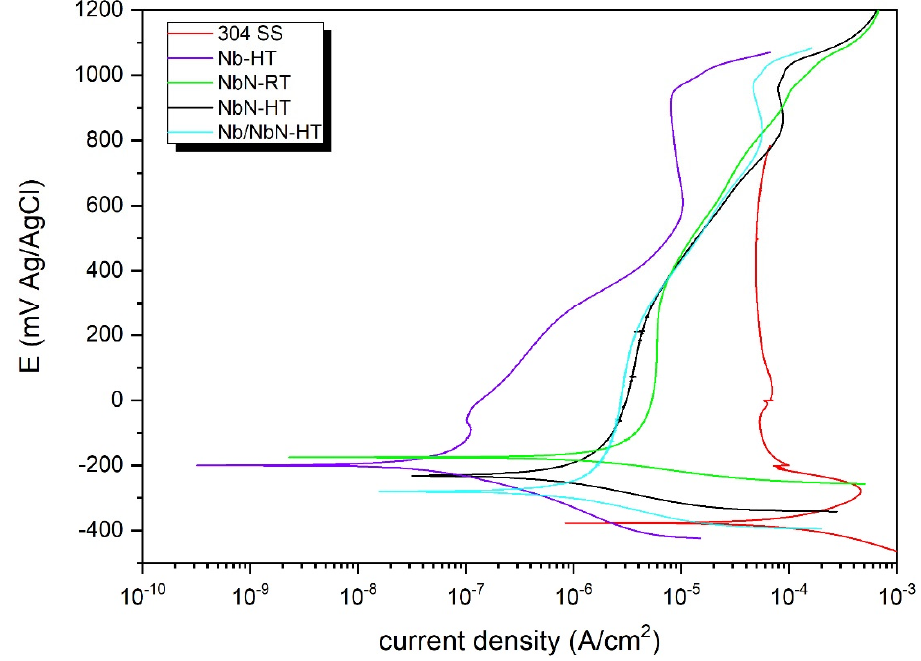
Figure 8. Potentiodynamic polarization curves of the uncoated 304 SS and different coatings in 1 M H 2 SO 4 + 2 mg/kg HF solution at 70 °C. Table 8. Electrochemical features of bare and coated 304 SS tested in simulated PEM fuel cell solution. ( E corr : corrosion potential and i corr : corrosion current density).